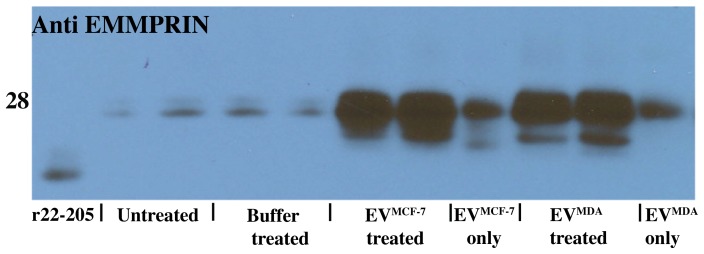
EMMPRIN is secreted upon stimulation with EVs.Western blot analysis of THP-1 cells shows the change in EMMPRIN secretion with and without stimulation with EVMCF-7 and EVMDA.